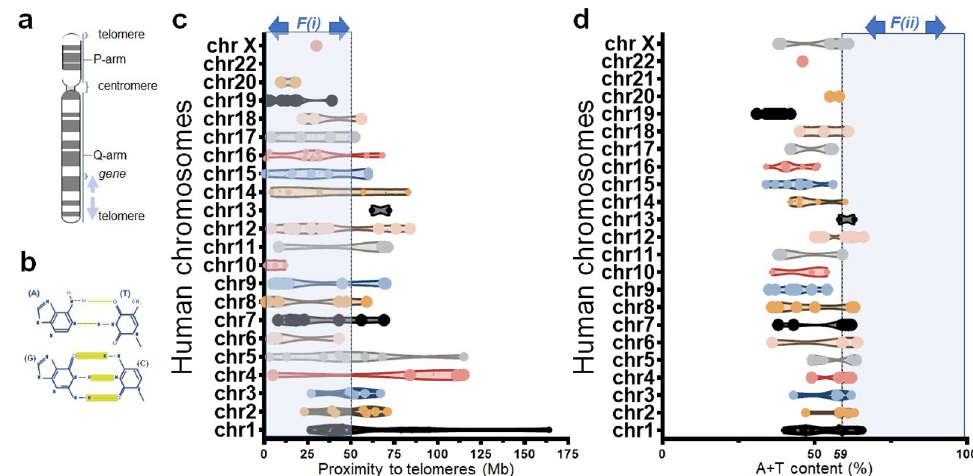
Fig 1. Genes encoding 129 druggable kinases with unknown disease associations. (a) a schematic diagram illustrating the relative positions of telomeres, centromere, each arm, and a gene in a human chromosome (b) illustration displaying two of four chemical bases comprising DNA, adenine and thymine whose combined (A+T) content is associated with high mutation rate in human chromosomes (c) Box and violin plots displaying the distribution of 129 kinases proposed as druggable proteins by the National Institute of Health (PA-19-034) with respect to proximity to telomeres over chromosome (chr) 1 to chr X. The candidate kinases are widely distributed over almost all chromosomes. F(i) indicates the proximity to the telomere. (d) Box and violin plots summarizing the full distribution of kinases over human chr 1 to chr X with respect to A+T content. F(ii) indicates high A+T content at > 59%. Shaded rectangles below arrows indicate subsets of genes encoding kinases satisfying F(i) and F(ii) in a and b, respectively.